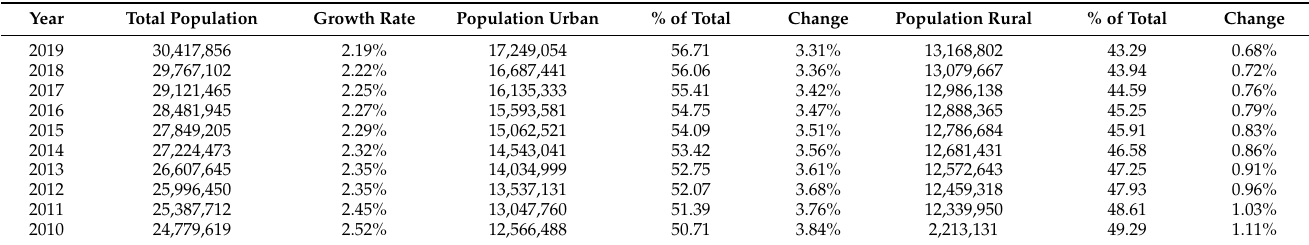
Table 4. Total population with urban and rural